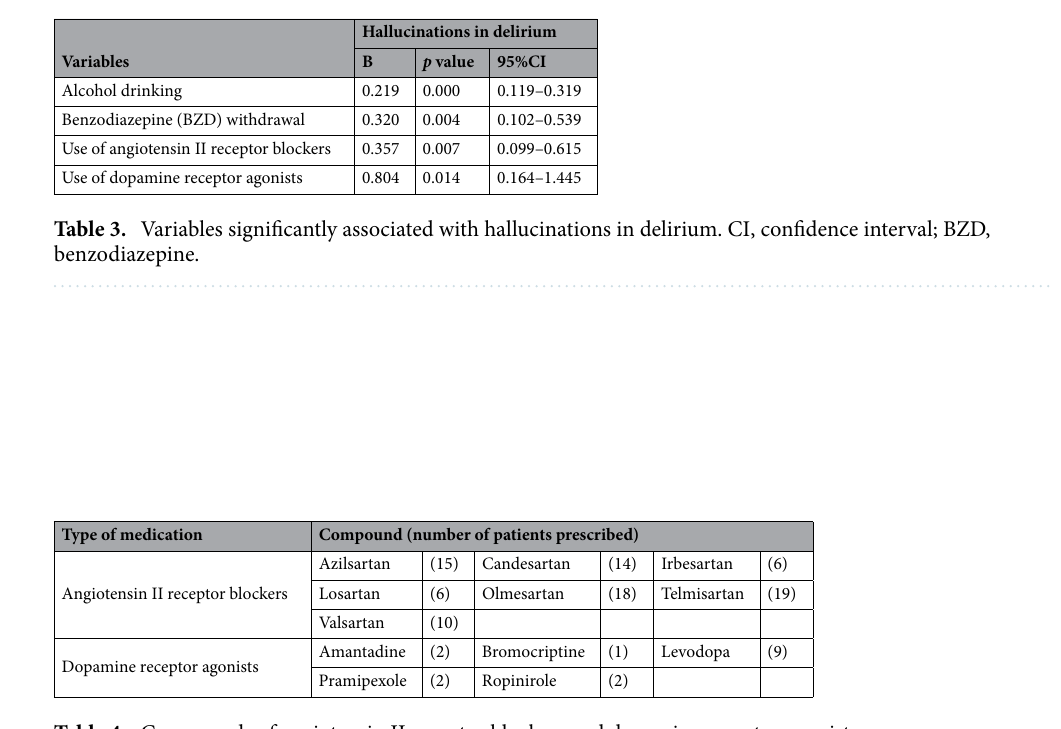
Table 4. Compounds of angiotensin II receptor blockers and dopamine receptor